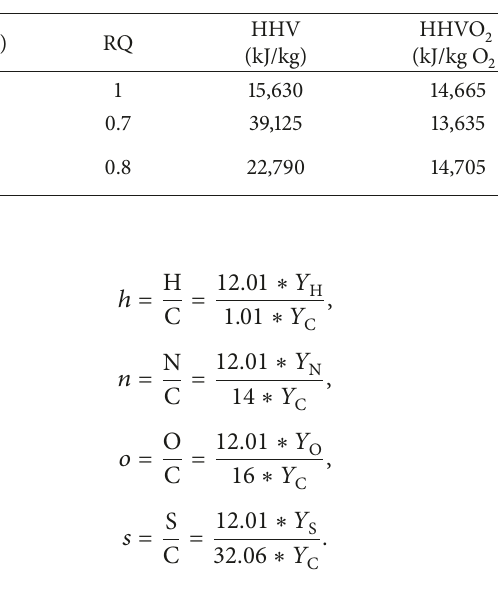
Table 1: Properties of macronutrients, adopted from Annamalai and Silva